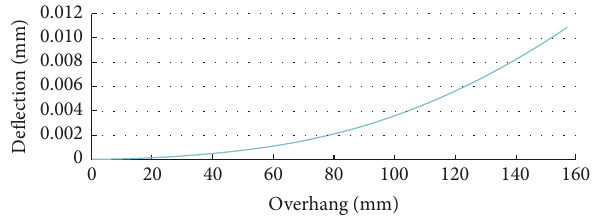
Figure 24: Influence curve of overhang on